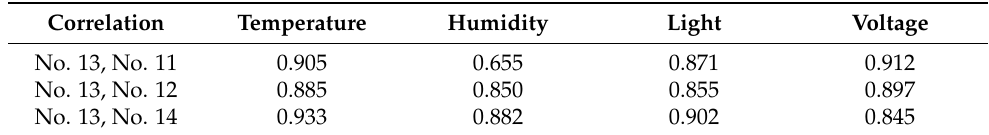
Table 6. Correlation of the multi-node.